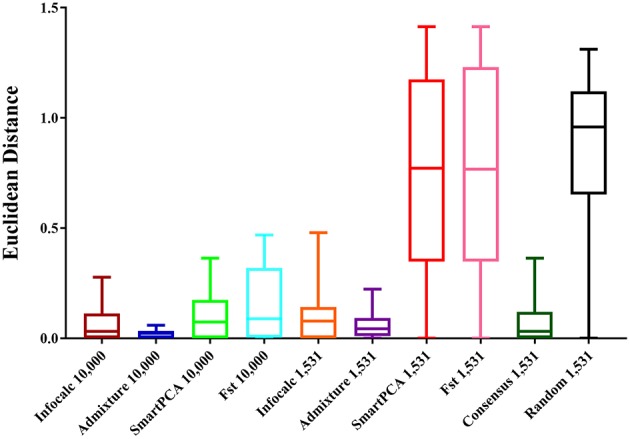
Box and whisker plots comparing the Euclidean distances between the admixture proportions of the gorilla genomes obtained from the CSS and those obtained from the reduced datasets. The number of SNPs the datasets are comprised of is mentioned in their nomenclature. The random dataset was comprised of 1,531 randomly generated SNPs from the CSS and the Consensus-1,531 dataset comprised of 1,531 SNPs that were detected by at least three of the four AIMs-determining approaches.